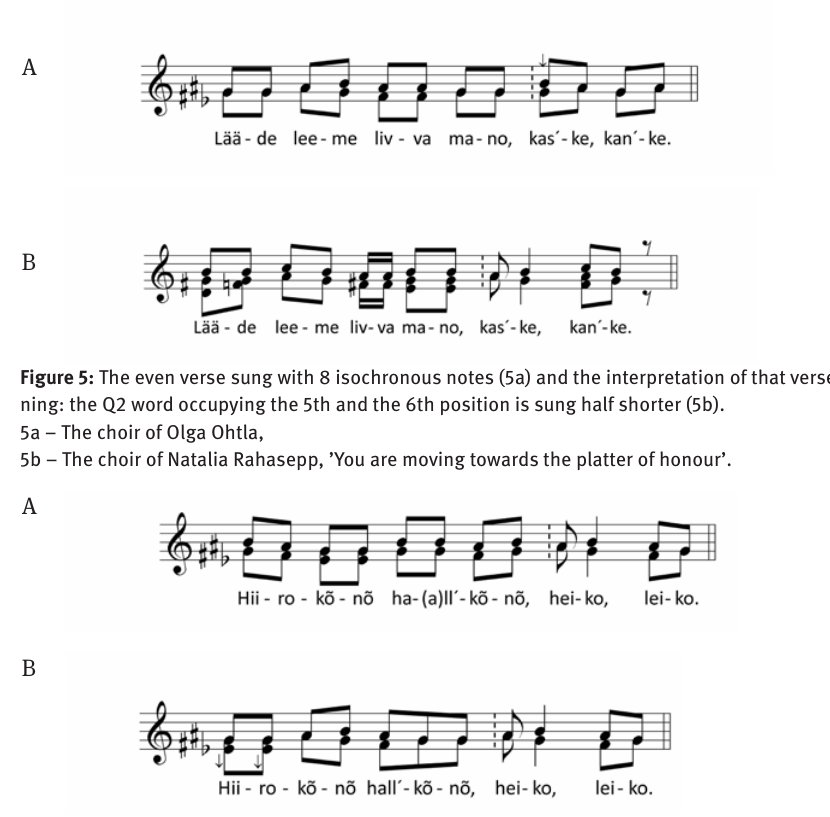
Figure 6: The even verse sung with 8 isochronous notes (6a) and the interpretation of a similar verse using the method of shortening: the Q3 initial syllable occupying the 5th and the 6th position is sung half shorter, with an isochronous one note